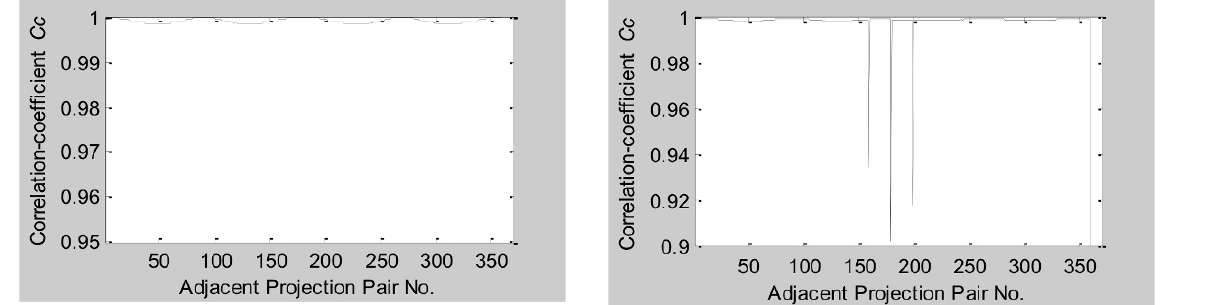
Figure 11. Correlation-coefficient for combined Rotational and Trans- lational motion corrupted case.